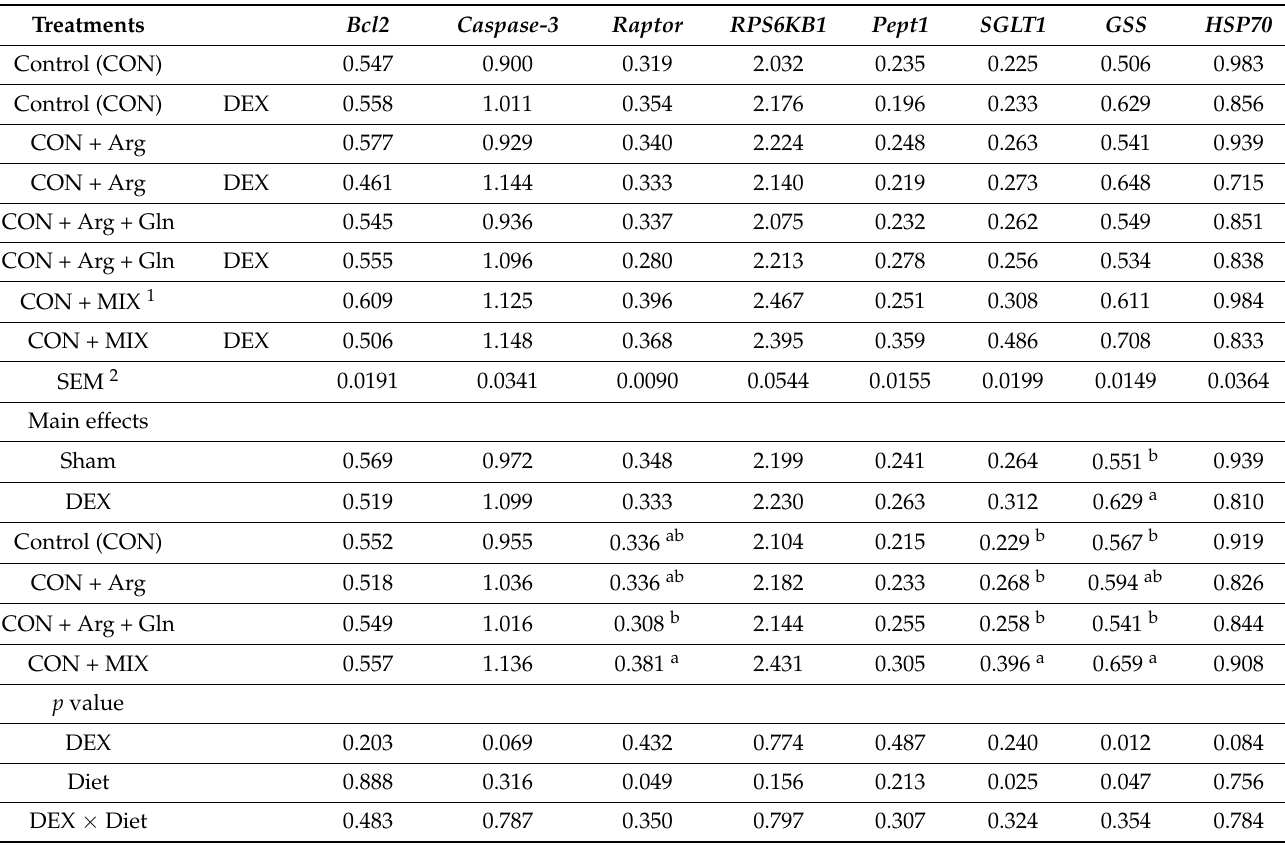
(Table 9). DEX did not change the sodium glucose cotransporter-1 (SGLT1) expression in the ileum but MIX increased ( p < 0.05) it compared with other three treatments. The level of mRNA for glutathione synthetase ( GSS ) was independently increased ( p < 0.05) in birds fed a diet completed with MIX compared with CON and Arg-Gln treatments as well as by DEX challenge ( p < 0.05). Relative gene expression of Caspase-3 tended ( p = 0.069) to upregulate by DEX challenge with no effect associated with diets. Feeding birds with a MIX diet increased ( p < 0.05) the expression of gene encoding Regulatory-associated protein of mTOR ( Raptor ) only compared with birds fed Arg-Gln treatment. Table 9. Relative gene expression of genes related to protein synthesis, apoptosis, nutrient transporters, and oxidative stress in ileum of broilers (day 21) subjected to dexamethasone (DEX) or sham injections (experiment 2).